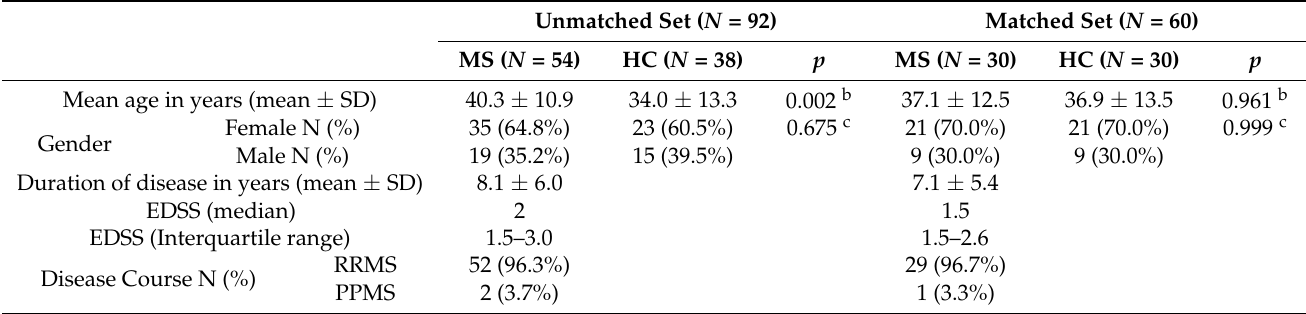
Table A1. Characterization of people with multiple sclerosis (MS) and healthy controls (HC), respectively, before and after propensity score matching ( N = 92); SD = Standard Deviation; EDSS = Expanded Disability Status Scale; RRMS = relapsing– remitting MS; PPMS = primary progressive MS; b p -value via t -test for differences between groups; c p -value via chi-squared test for differences between groups.